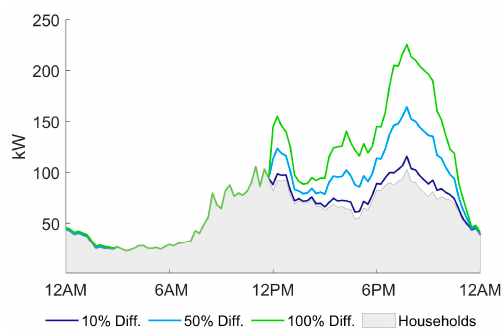
Figure 5. Charging profiles and household electricity demands without control (UC).